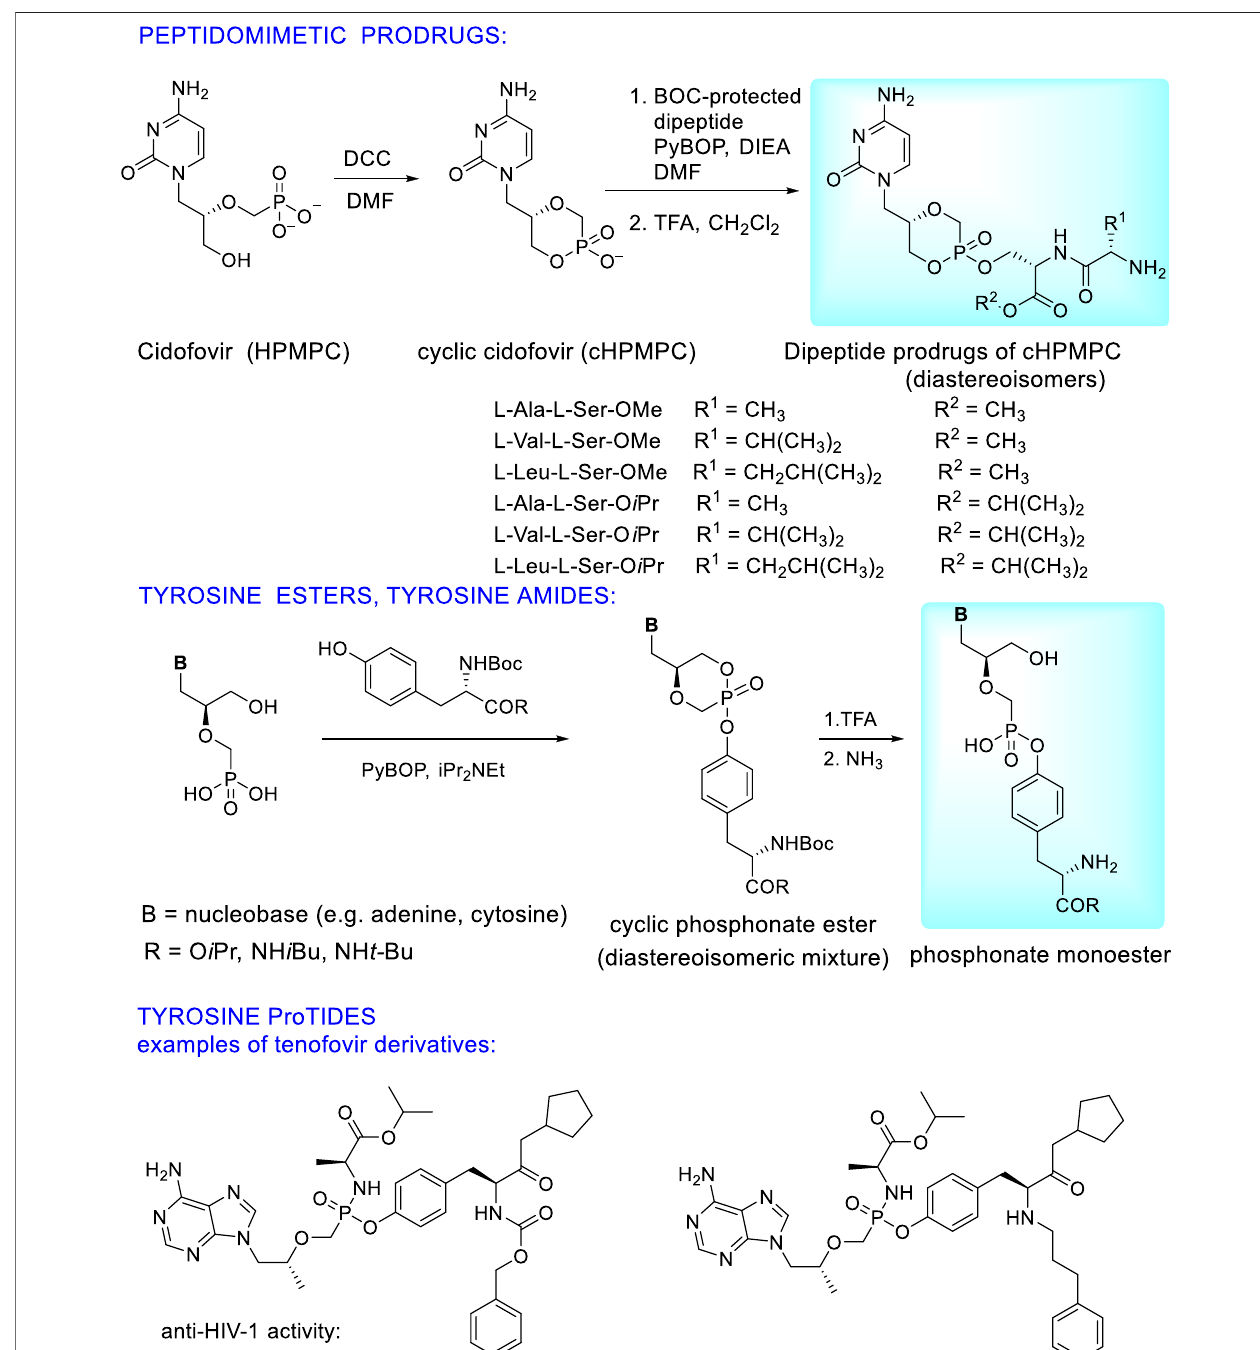
Frontiers in Chemistry |